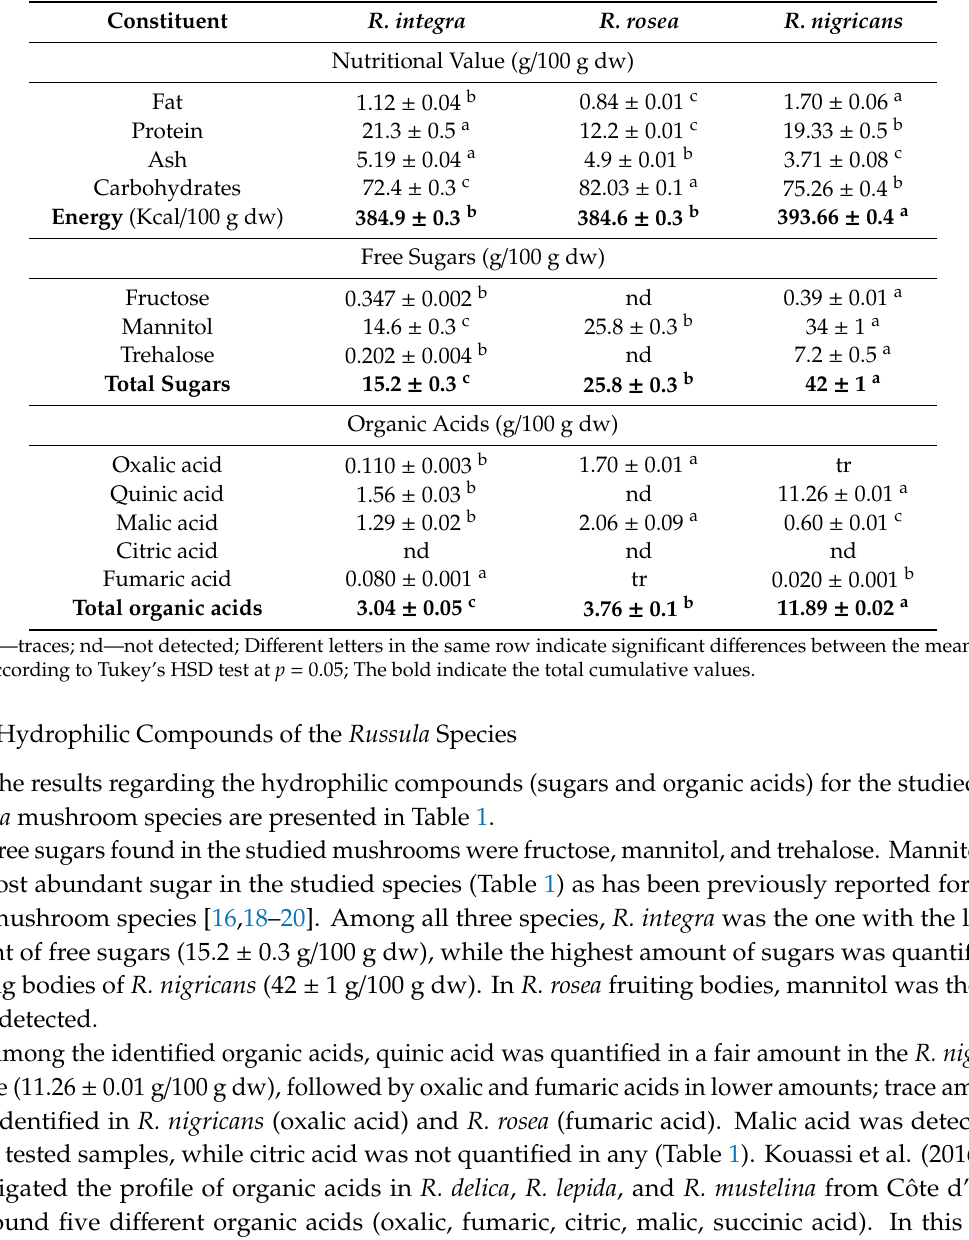
Table 1. Nutritional value and free sugars and organic acids composition of the studied mushrooms (mean ± SD, n =